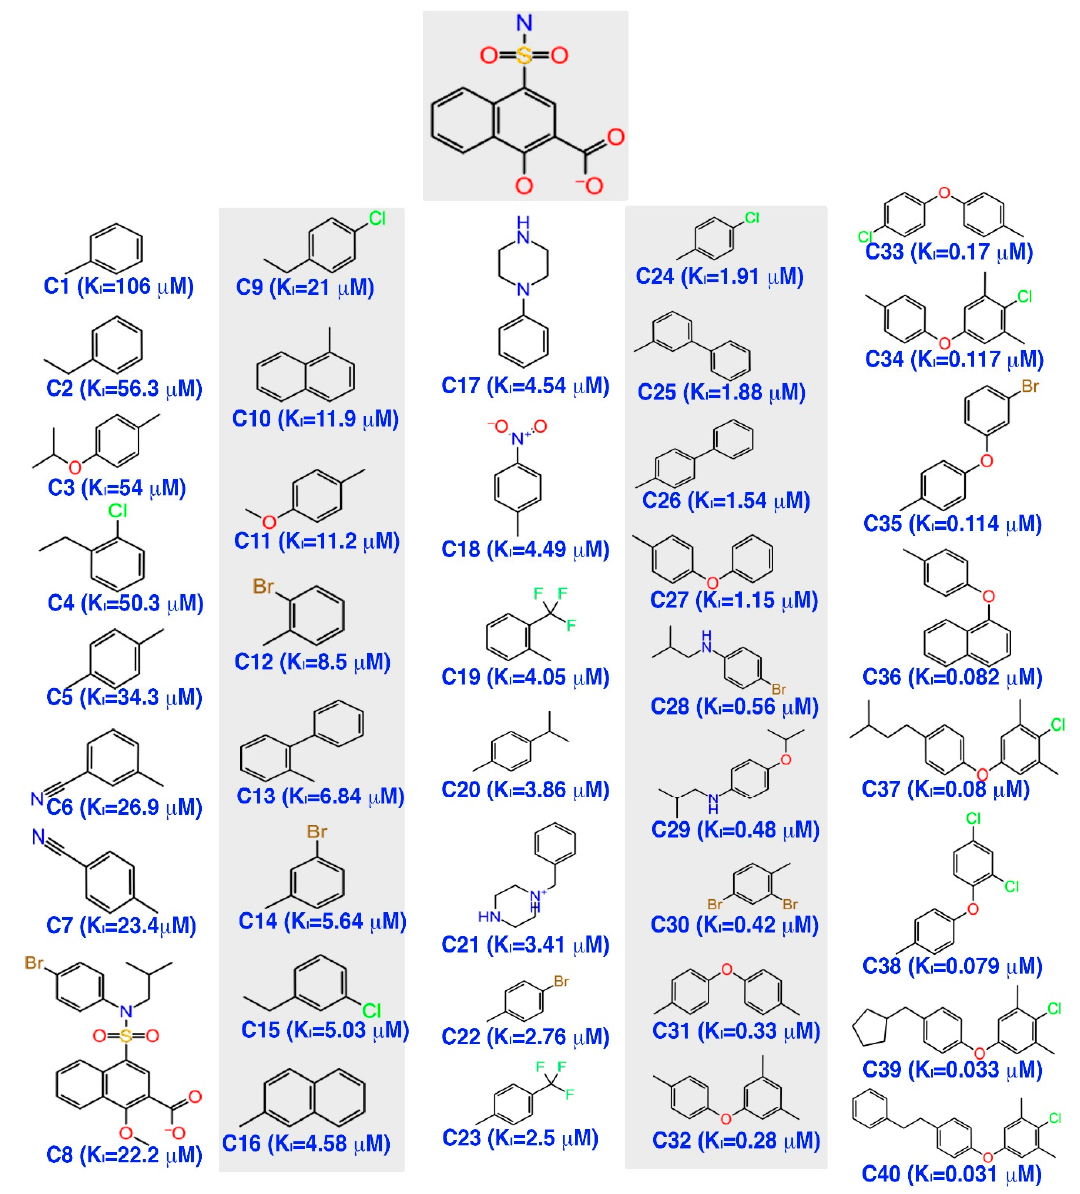
Figure 1. The chemical dataset used for the pharmacophore-based 3D-QSAR studies (ChEMBL— 3779852)